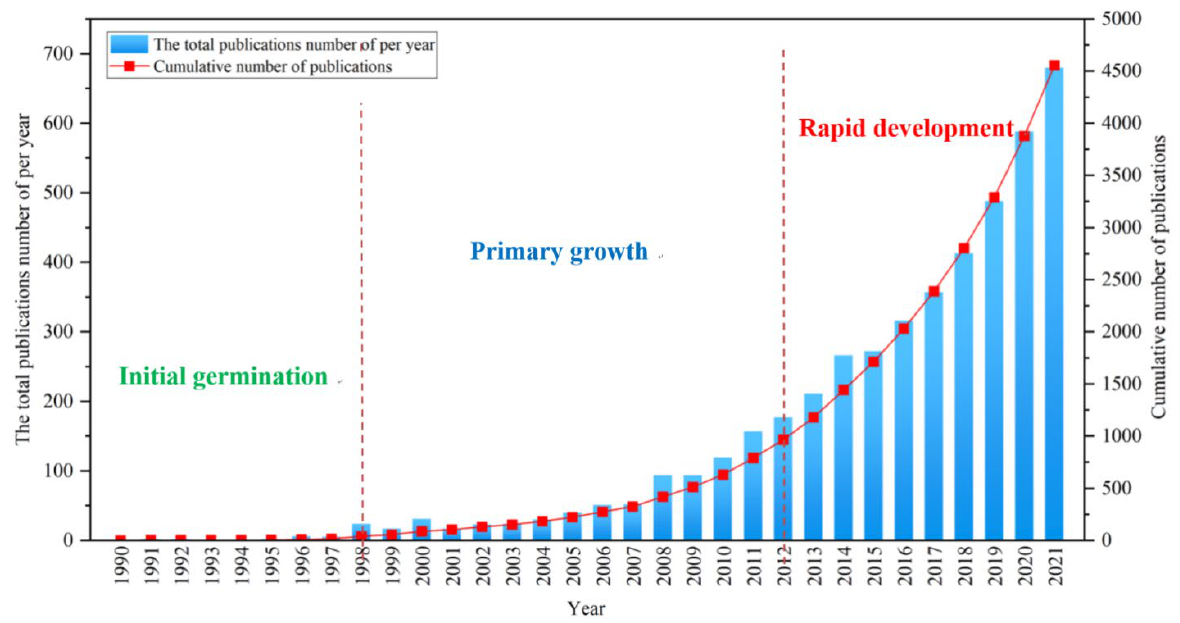
Figure 1. Distribution of the number of literature in the field of climate change impact on crop pests and diseases research from 1990–2021.